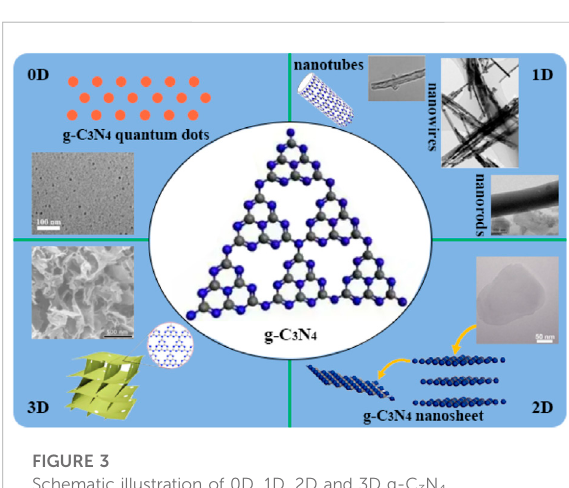
FIGURE 3 Schematic illustration of 0D, 1D, 2D and 3D g-C 3 N 4